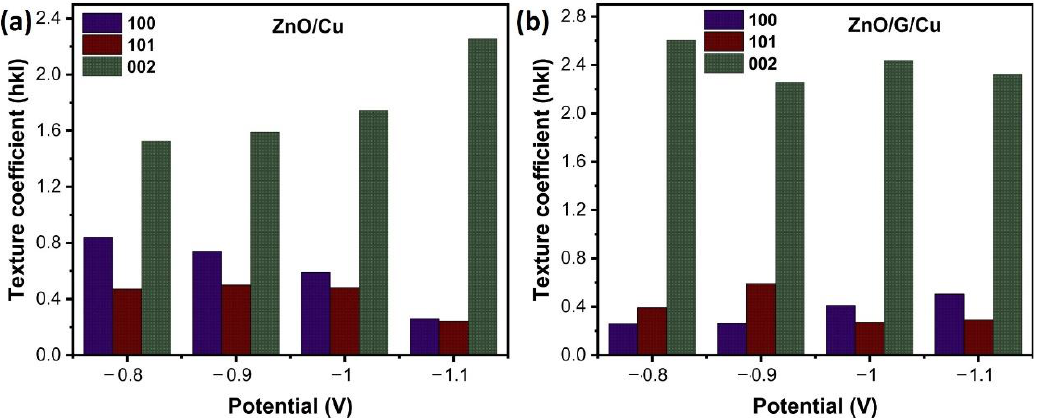
Figure 5. Texture coefficient (TC) of ( a ) ZnO/Cu and ( b ) ZnO/G/Cu at different applied potentials.